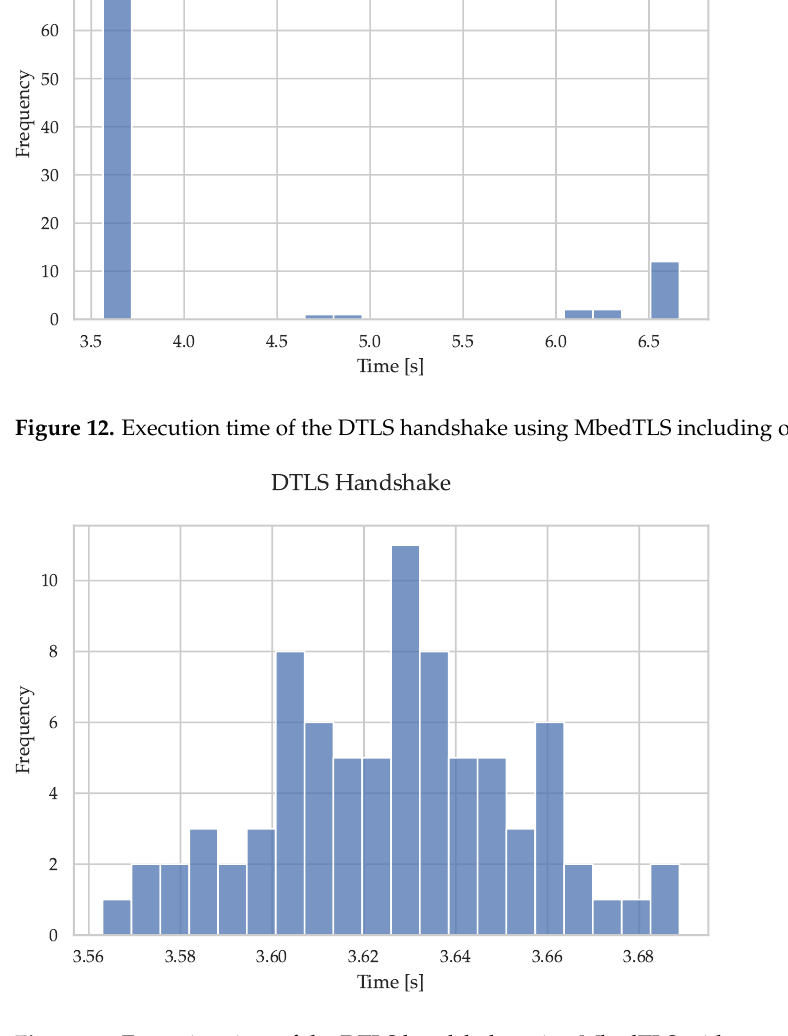
Figure 13. Execution time of the DTLS handshake using MbedTLS without outliers differing more than 20% from the